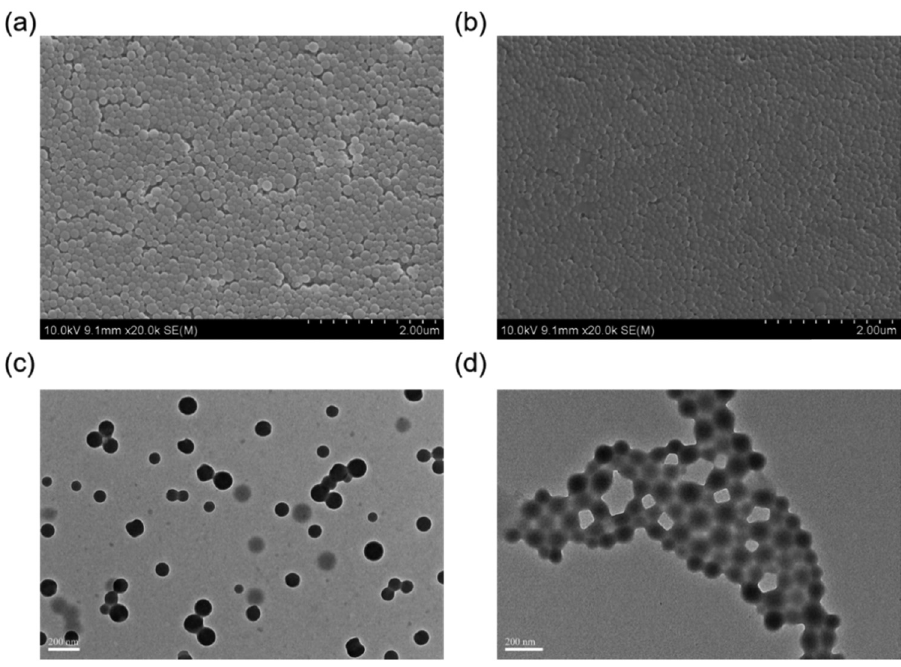
Figure 2: The morphology of the obtained nanospheres: ( a ) SEM image of CS Ns, ( b ) SEM image of CS - I Ns, ( c ) TEM image of CS Ns, and ( d ) TEM image of CS - I Ns.